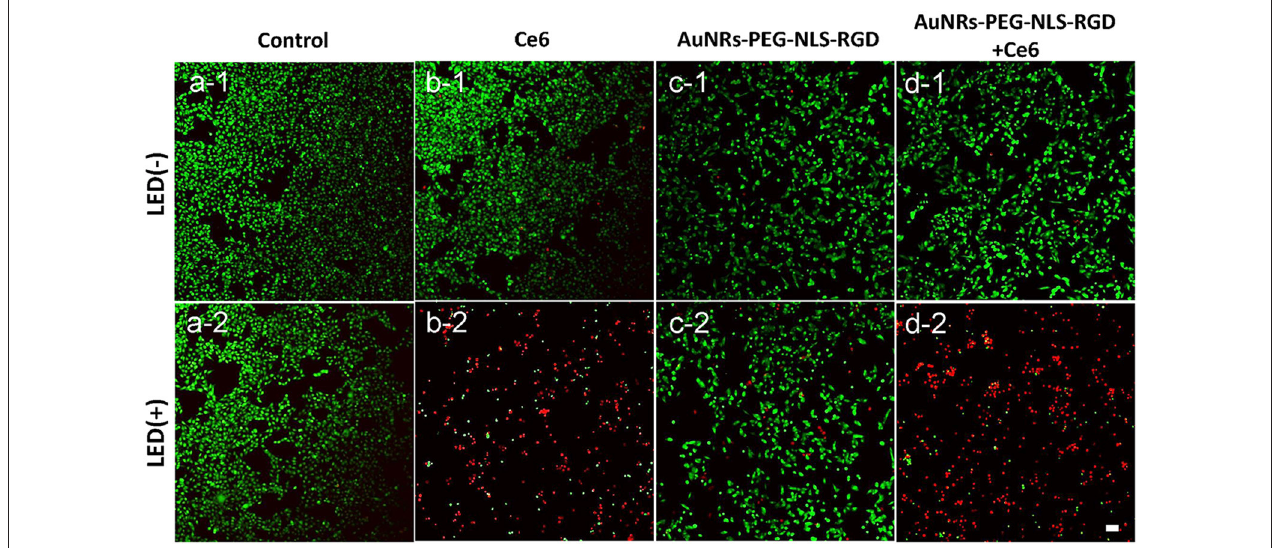
FIGURE 4 | Confocal fluorescent images of B16 cells after they were incubated with Ce6 (b) and AuNRs-PEG-NLS-RGD (c) and AuNRs-PEG-NLS-RGD + Ce6 (d) , without (1) and with (2) the irradiation of a 650nm lamp (18 mW/cm 2 ) for 5min, while the cells without and with the light irradiation were used as the control samples (a) . Cells were stained with Calcein-AM (green) and PI (red) for distinguishing the living and dead cells. The scale bar is 20 µ m.